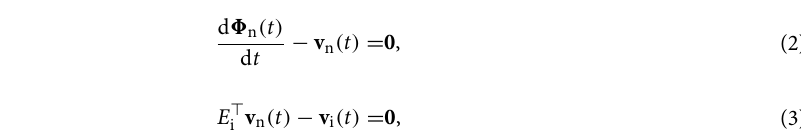
Figure 1. Memristor-network-based RC system. ( a ) System architecture composed of preprocessing, input, reservoir, and readout parts. An input time series data is preprocessed and then fed into the memristor network through the voltage source. The memristor network consists of N m memristors, N n circuit nodes, and N i voltage sources. The current signals are measured as a reservoir state and processed in the readout part. The output weight matrix W out is optimized by linear regression in the training process. ( b ) The linear drift model of a memristor 34 , which is equivalent to a series of a low resistance state (LRS) with resistance R ON and a high resistance state (HRS) with resistance R OFF ( ≫ R ON ) . The ratio between the lengths of the LRS and HRS changes in time depending on an applied voltage. ( c) Current–voltage ( I – V ) characteristics of a single memristor model in response to a sinusoidal voltage signal for different values of r = R OFF / R ON . ( d ) Normal distributions of R ON ¯ R with mean ON = 100 (cid:31) and standard deviation σ ¯ R ON for different values of σ controlling the degree of the device-to-device variation. ( e ) Examples of four types of network structures, including a ring with unidirectional polarity (Ring-UP), a ring with random polarity (Ring-RP), a random network with unidirectional polarity (Rand-UP), and a random network with random polarity (Rand-RP). The memristors indicated by the arrows in the Ring-UP and Ring-RP types have opposite polarities. The networks of the Rand-UP and Rand-RP types are generated by randomly adding non-local memristor branches to those of the Ring-UP and Ring-RP types,